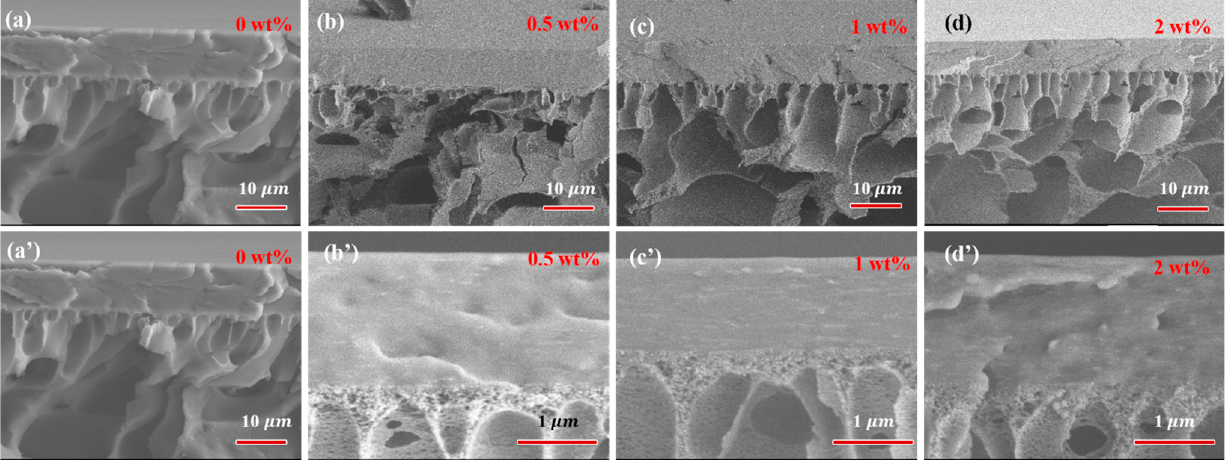
Figure 6. Cross-section morphology of GR/PVA ( up ) and GO/PVA MMMs ( down ). ( a , a’ ) pure PVA membrane; ( b , b’ ) filler loading of 0.5 wt%; ( c , c’ ) filler loading of 1 wt%; ( d , d’ ) filler loading of 2 wt%.